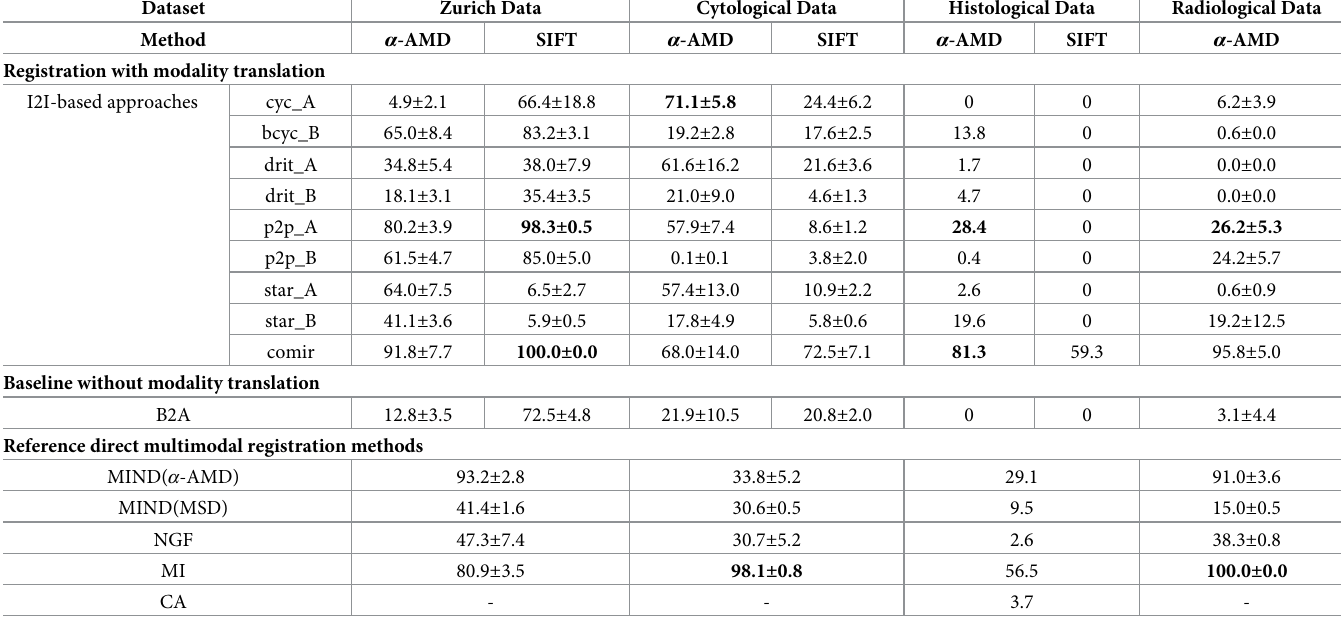
Table 2. Overall registration success rate (in percent) for the evaluated methods on four datasets. Larger is better. The success rate λ is aggregated over all transforma- tion levels for each dataset. Standard deviations are taken over the 3 folds for Zurich, Cytological and Radiological data. cyc , drit , p2p , star , comir , MIND( α - AMD),MIND(MSD) , NGF , MI and CA denote the methods CycleGAN, DRIT++, pix2pix, StarGANv2, CoMIR, MIND+ α -AMD-based registr., MIND+MSD-based registr., NGF, MI maximisation and CurveAlign, respectively. _A (resp. _B) denotes using generated Modality A (resp. B) for registration. B2A refers to the multimodal registration performance on the acquired images without modality translation. MI , MIND and NGF provide reference performance of good conventional multimodal regis- tration methods. For each dataset, the best I2I-based approach, as well as the overall best performing (multimodal) approach, are